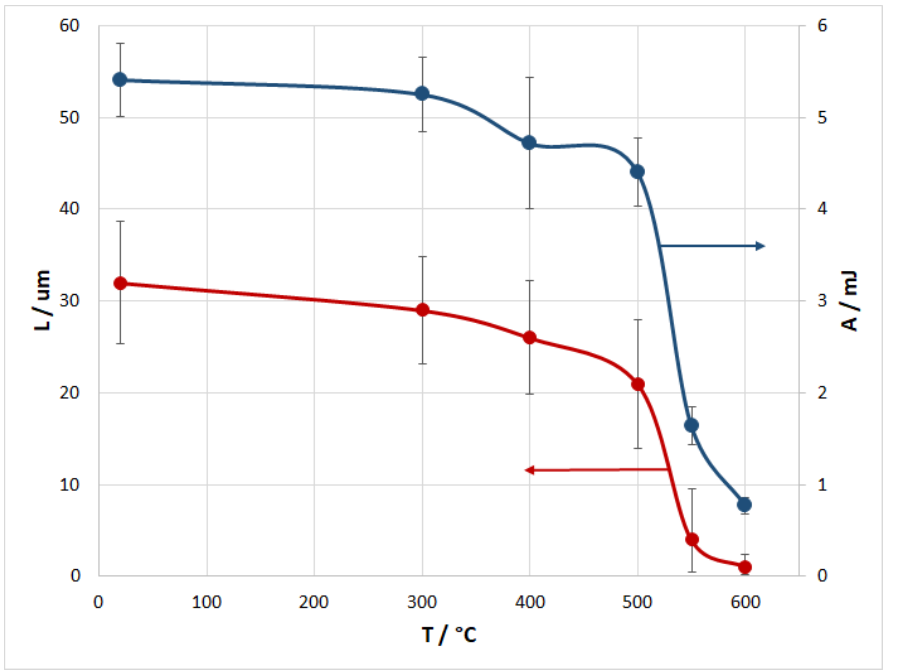
Figure 8. Dependence of the length of the pulled-out fiber part and fracture work on the treatment temperature.